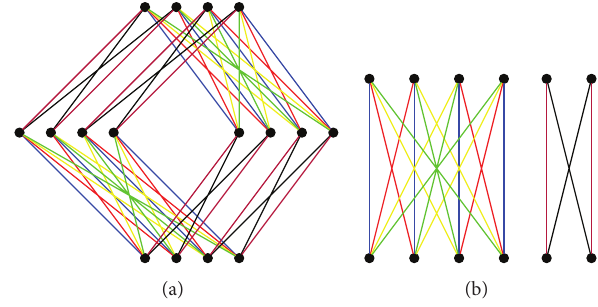
Figure 6: (a) A 2 D Adinkra with dashes omitted. (b) Picking any vertex and looking at connected components give us a pair of 1D Adinkras 𝐴 0 𝐿 and 𝐴 0 𝑅 , the product of which contains as a quotient the original Adinkra; in this case we quotient via a 1-dimensional code 𝐾 of size 2 1 = 2 , obtaining the desired 8 × 4/2 = 16